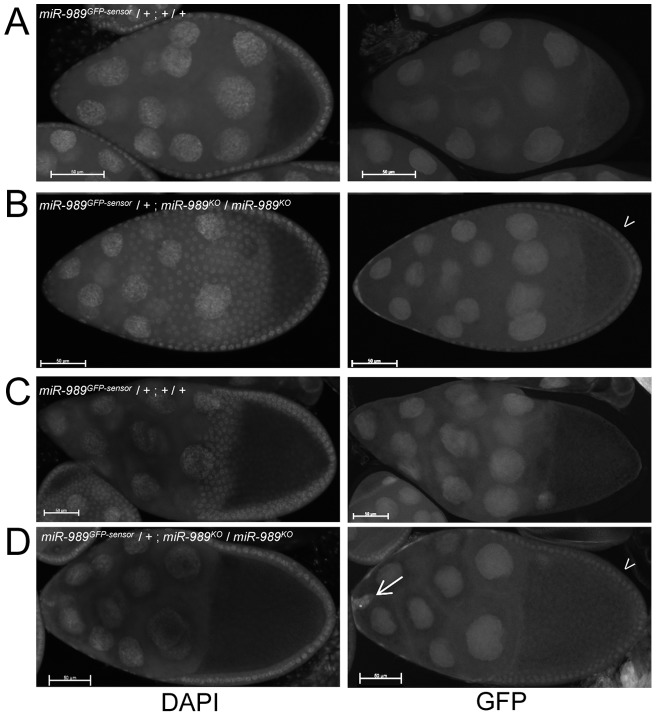
A miRNA sensor suggest somatic miR-989 activity.Stage 8 (A, B) and Stage 10A (C, D) eggchambers expressing a miR-989 GFP sensor in a wild type (A, C) or in a miR-989 mutant background (B, D). While the GFP sensor was expressed at similar levels in the germ line cells in both genetic backgrounds, it was not detectable in the somatic follicle cells in the wild-type egg chambers. However, follicle cells were positively labelled by the sensor in the absence of miR-989. Note that the sensor also labels the border cells in (D) (arrow).